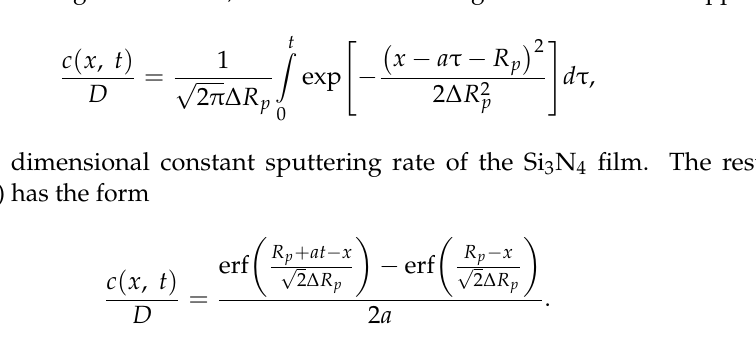
SRIM program: R p = 2.2 nm and ∆ R p = 1.1 nm. Figure 16 shows distribution (54) con- structed with allowance for an arbitrarily chosen nitrogen nitride film sputtering rate ( dx / dt ) sput = a = 0.2 nm/s.